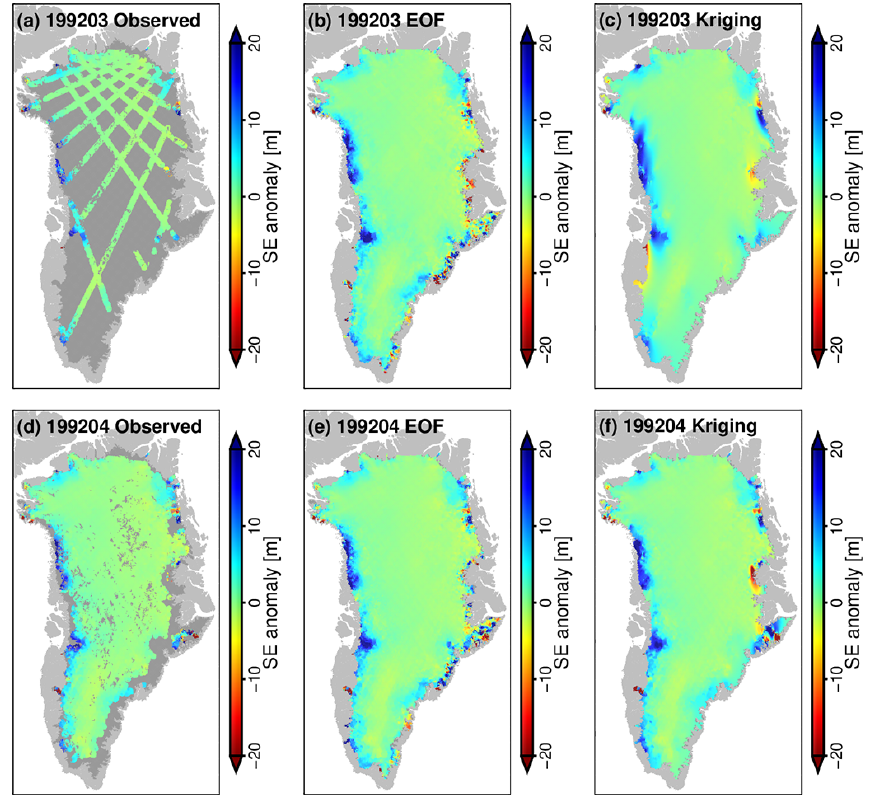
Figure 3. Interpolation performance of EOF reconstruction and ordinary kriging: panels (a) , (b) , and (c) are the results for the March 1992 (199203) observation, EOF reconstruction, and ordinary kriging interpolation, respectively, and panels (d) , (e) , and (f) are the same for April 1992 (199204).